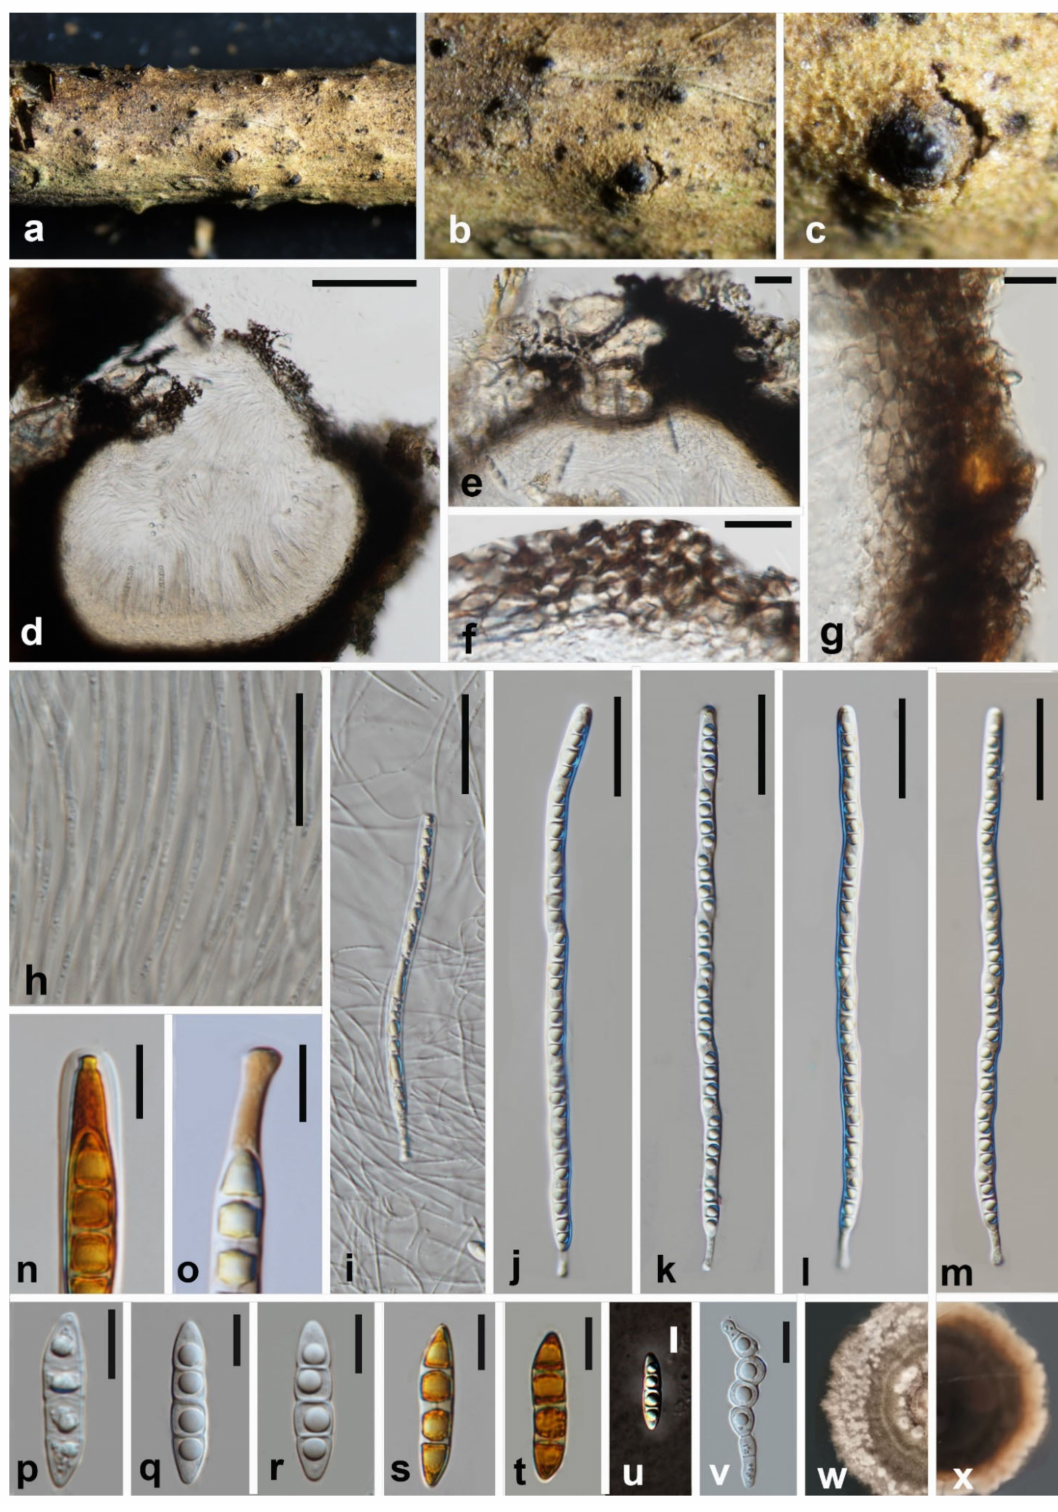
Figure 2. Melomastia fusispora (HKAS 121316, holotype). ( a – c ) Ascomata on the substrate. ( d ) Vertical section of the ascomata. ( e ) Vertical section of the ostiole. ( f , g ) Peridium ( h ) Pseudopa- raphyses. ( i – m ) Asci. ( n ) Ocular chamber in Lugol’s iodine. ( o ) Pedicel in Lugol’s iodine. ( p – u ) Ascospora. (( s , t ) in Lugol’s iodine, ( u ) in India ink). ( v ) Germinating ascospore. ( w ) Upper view of the colony on PDA after 14d. ( x ) Reverse view of the colony on PDA after 14d. Scale bars: ( d ) = 100 µ m, ( e , g ) = 20 µ m, ( f , n – u ) = 10 µ m, ( h – m ) = 40 µ